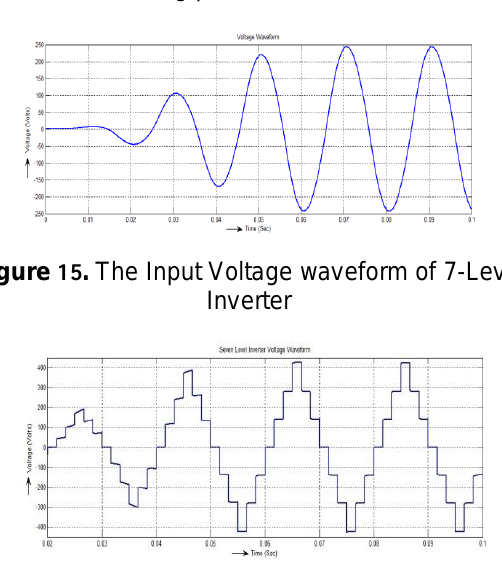
Figure 14 . Switching pulses for Seven Level Inverter